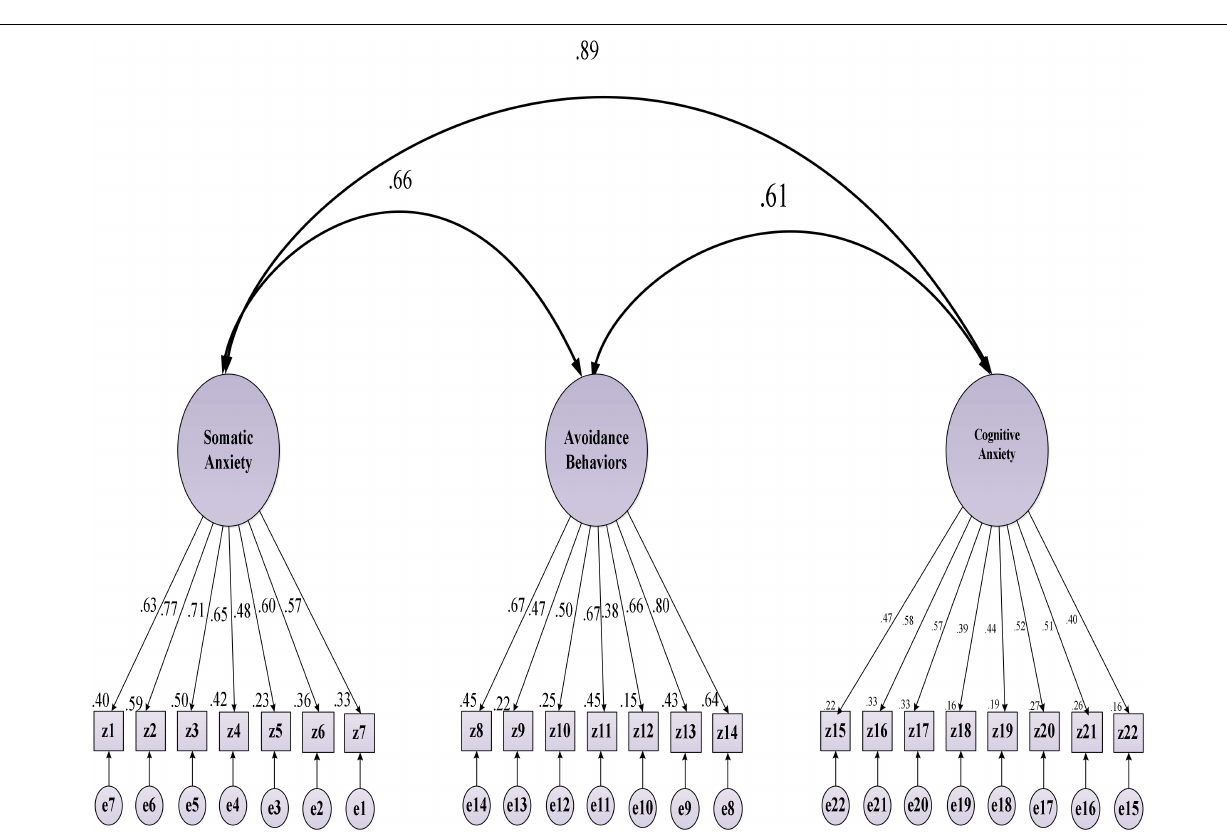
Frontiers in Psychology |